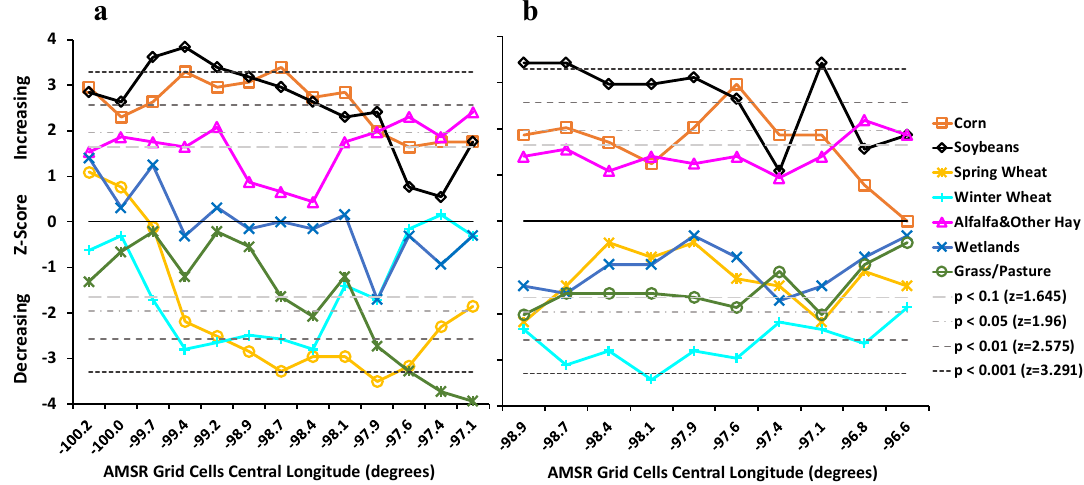
Figure 5. Mann–Kendall trend graphs for (a) ND transect for 2003 to 2016 and (b) SD transect for 2006 to 2016. Graph shows z-score as a function of longitude for seven main CDL cover types. The gray dashed lines present the z-scores at various p-values.